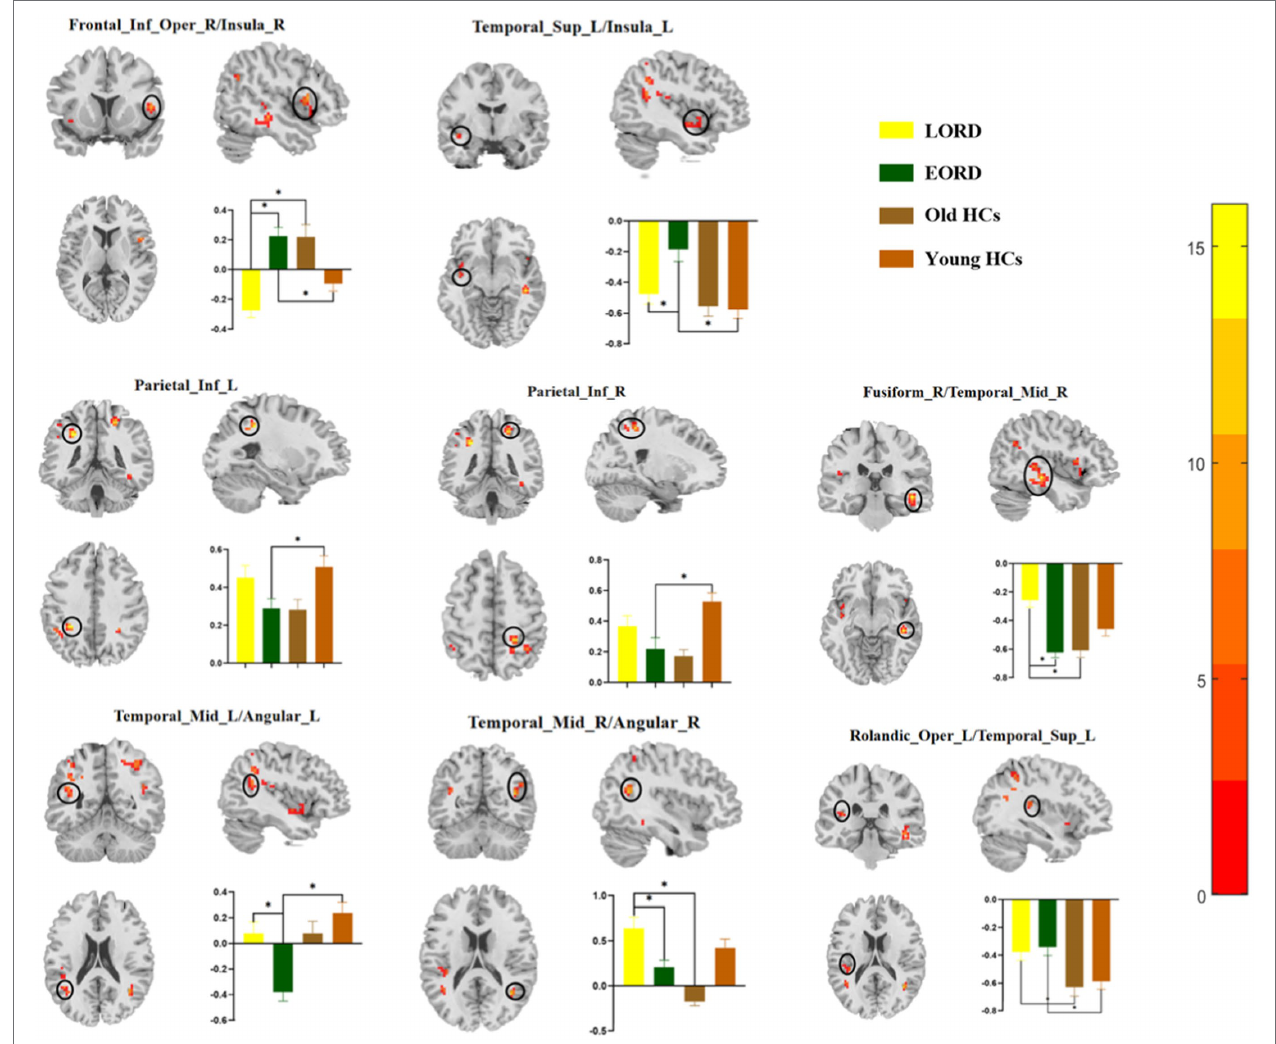
FIGURE 2 | Post-hoc two-sample t -tests (Bonferroni corrected) comparison showing ReHo values differences at peak voxel between each pair group (EORD vs. young HCs, LORD vs. old HCs, and LORD vs. EORD). EORD, early onset recurrent depression; LORD, late onset recurrent depression; young HCs, young healthy controls; and old HCs, old healthy controls. Frontal_Inf_Oper_R/Insula_R = right inferior frontal gyrus/right insula; Temporal_Sup_L/Insula_L = left superior temporal gyrus/left insula; Parietal_Inf_L = left inferior parietal lobule; Parietal_Inf_R = right inferior parietal lobule; Fusiform_R/Temporal_Mid_R = right fusiform gyrus/right middle temporal gyrus; Temporal_Mid_L/Angular_L = left middle temporal gyrus/left angular gyrus; Temporal_Mid_R/Angular_R = right middle temporal gyrus/right angular gyrus; and Rolandic_Oper_L/Temporal_Sup_L = left rolandic operculum gyrus/left superior temporal